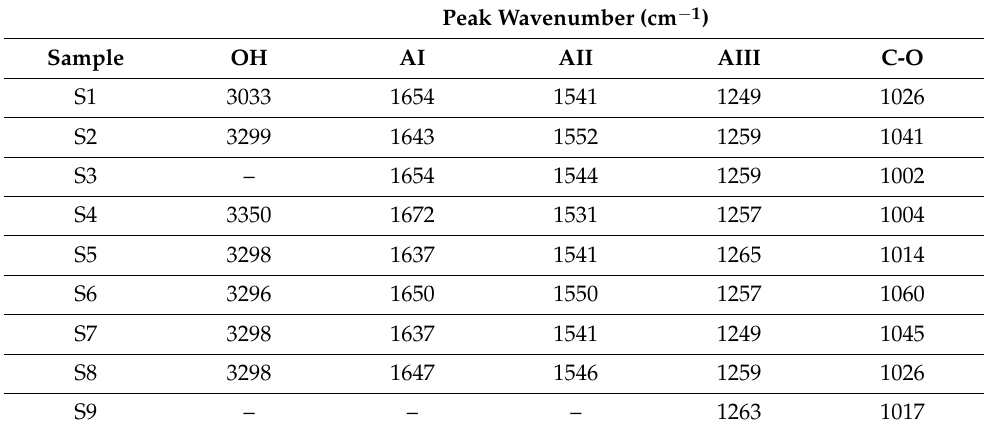
Table 3. Assignment of ATR-FTIR identified peaks.